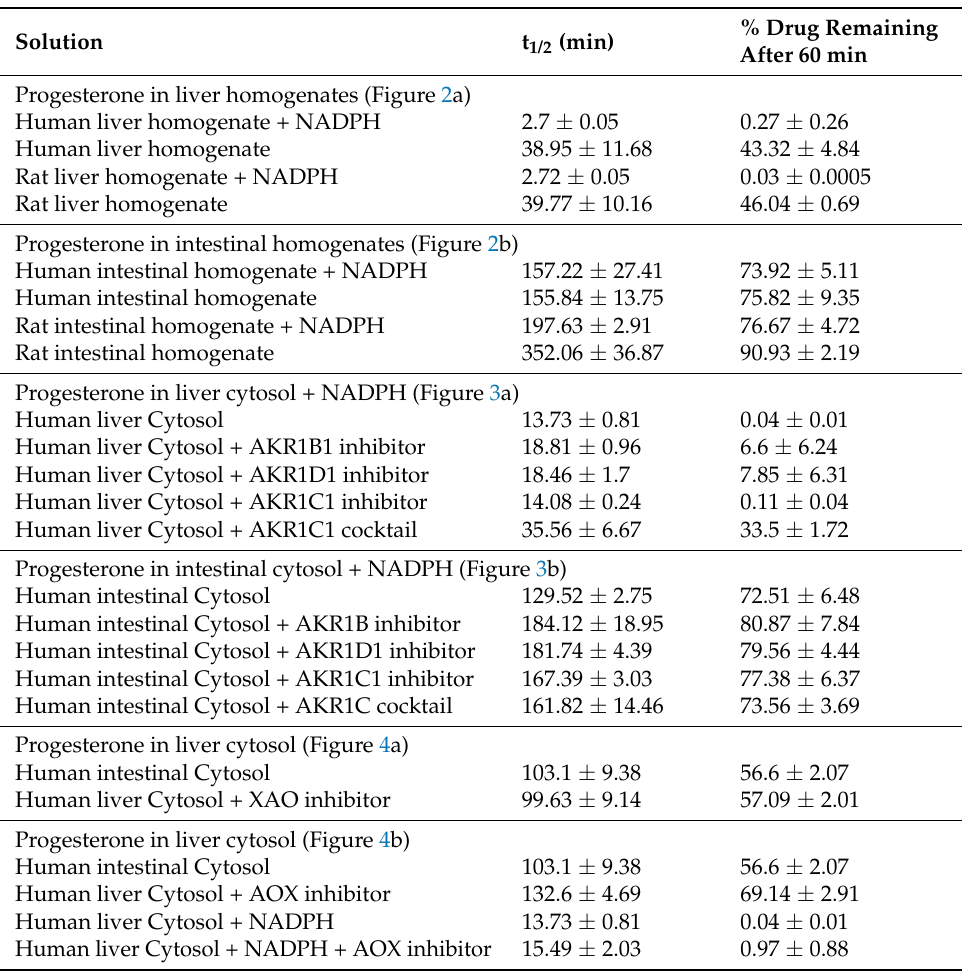
Figure 4. Stability profile of progesterone in human liver cytosol in the absence of NADPH (unless stated) and with the addition of XAO inhibitor ( a ) AOX inhibitor ( b ) (error bars are +/ − SD). Table 1. Half-life (t 1/2 ) and concentration of progesterone after 60 min of incubations with named solution.